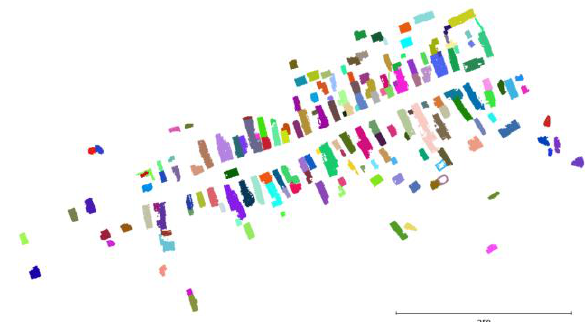
Figure 8 . Clustered roof points, different clusters are marked by assorted colors. Figure 9 . Clustered building points, different colours mark the corresponding wall and roof sub-point clouds.